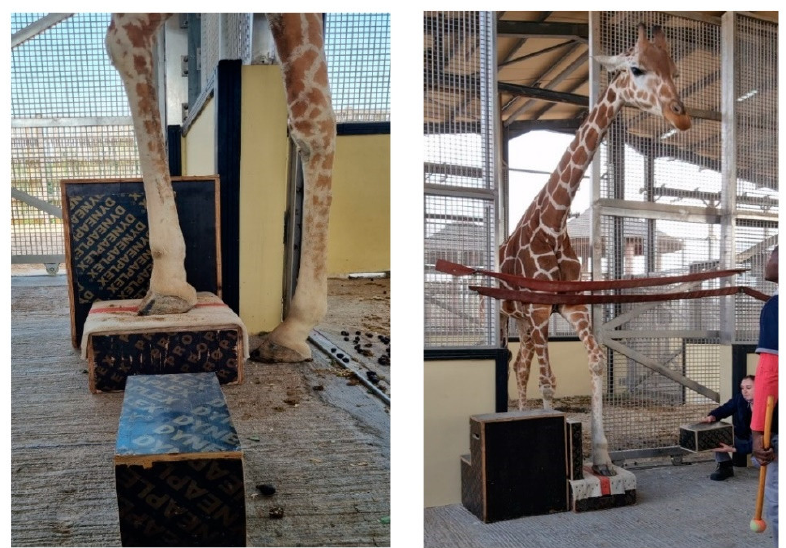
Figure 2. The Mock-up Radiograph Cassette and Unit set up with animal keepers demonstrating use during the early stages of desensitization.